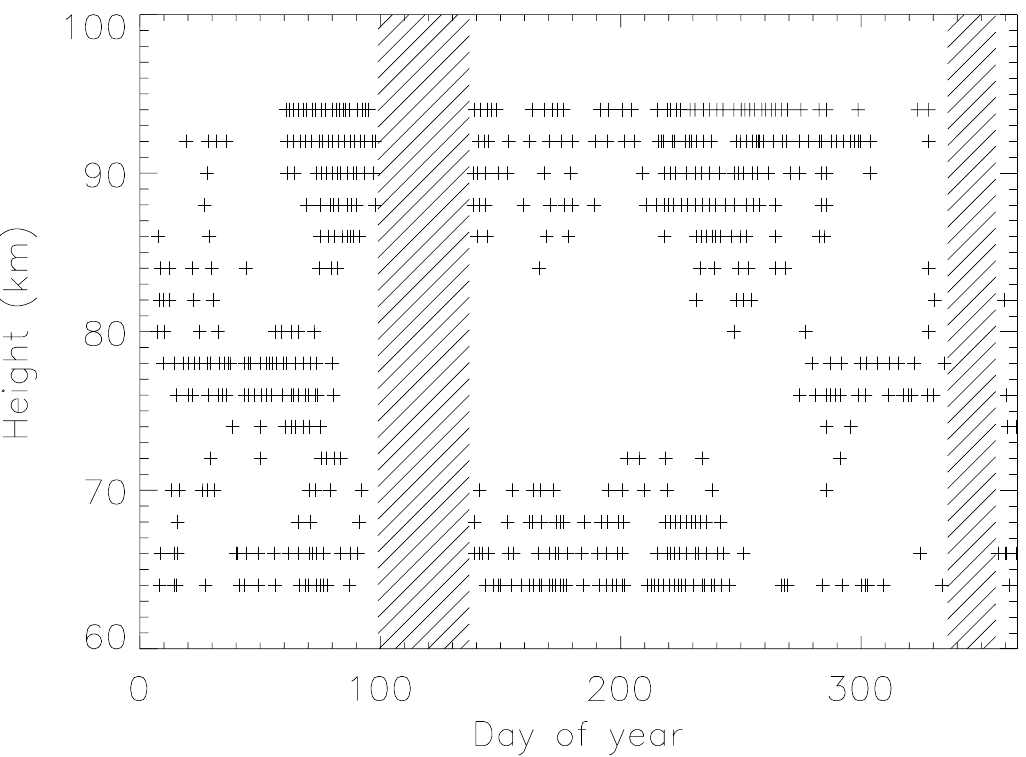
Fig. 3. The annual variation of peak heights for persistent events, showing the three preferred heights bands at 65km, 77km, and 90km. (Shaded sections represent gaps in the available